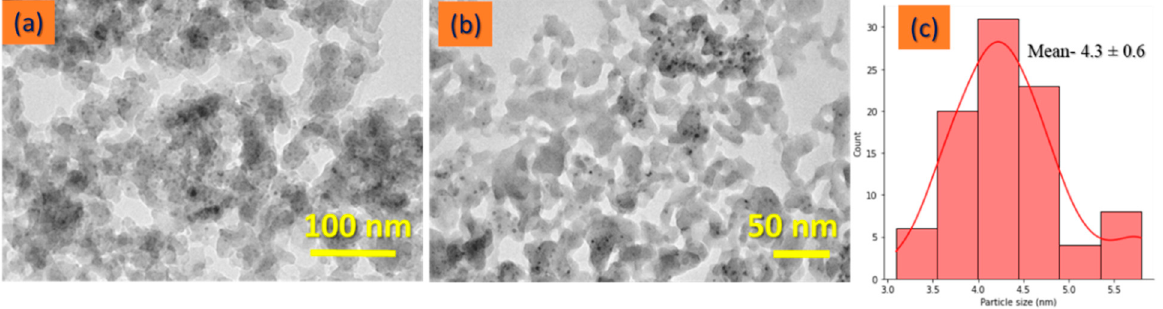
Figure 7. ( a , b ) TEM images of 5 wt% Cu/SiO 2 catalyst with different resolution and ( c ) average particle size.